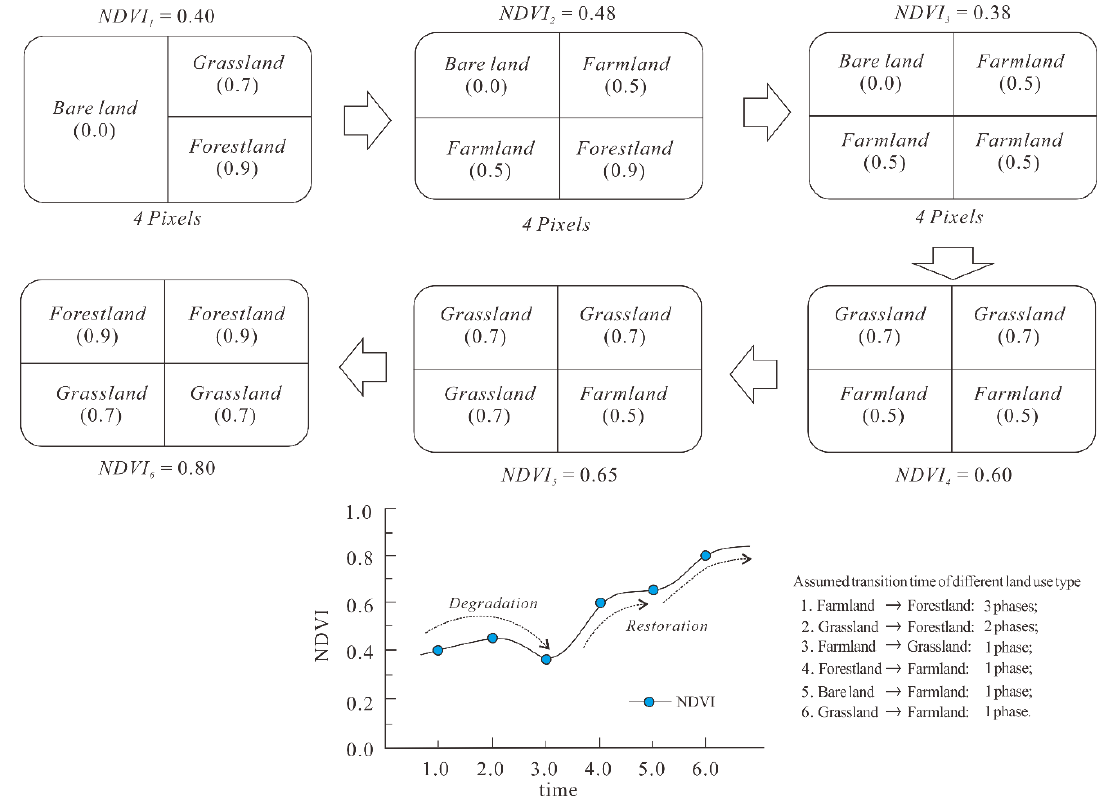
Figure 8. A conceptual model of NDVI responses to human